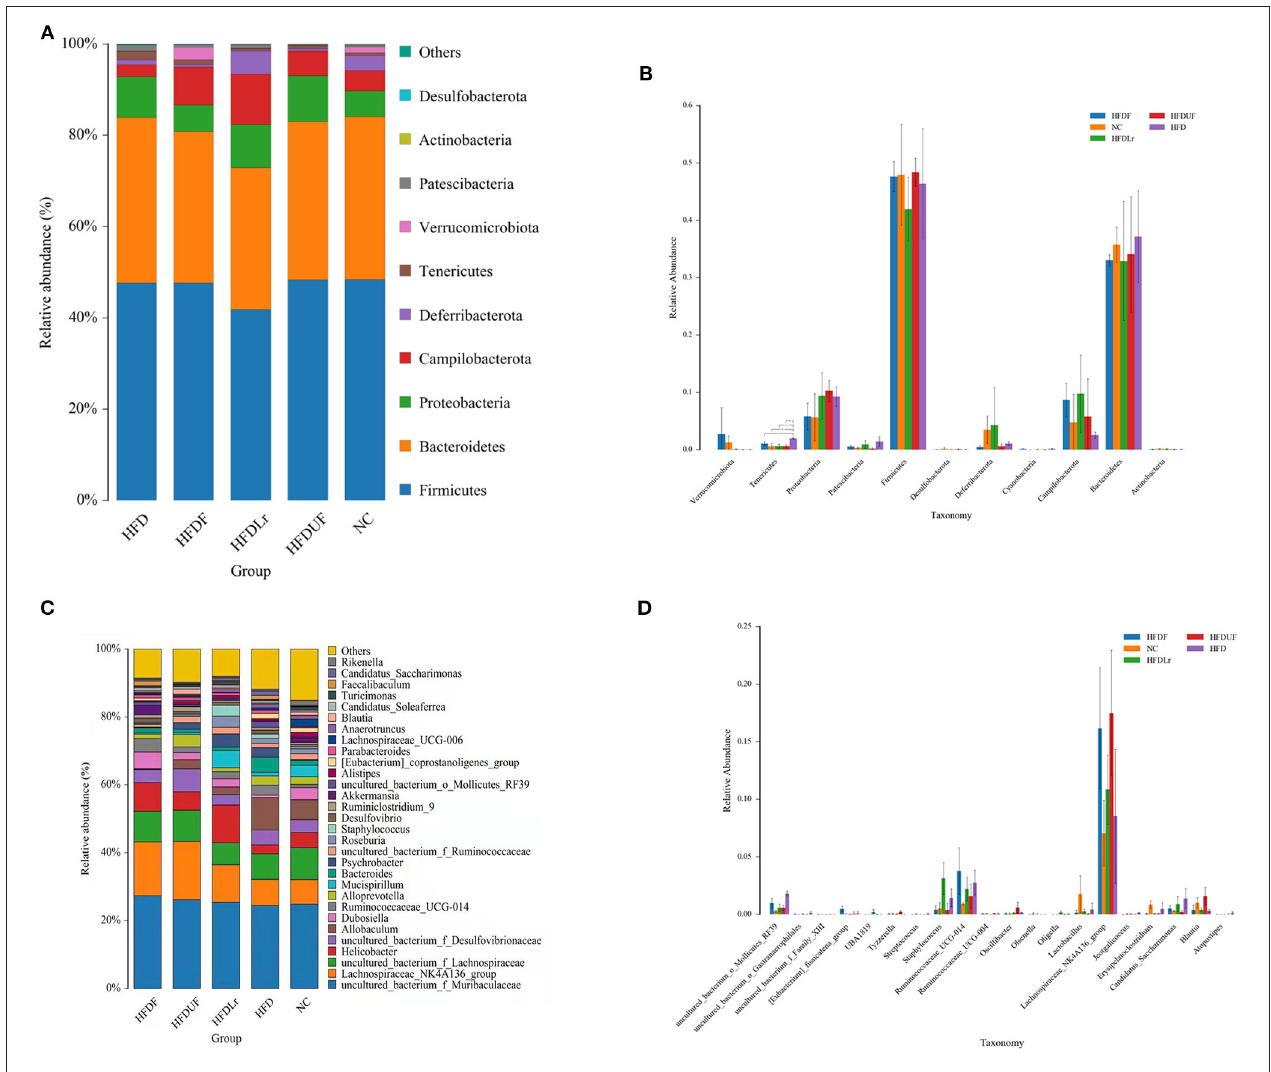
FIGURE 8 | The effects of CSM on intestinal microbiota in the HFD-fed mice. (A) Relative abundance of the intestinal microbiota at the phylum level; (B) histogram derived from the ANOVA statistical analysis of the different treatment groups at the phylum level; (C) relative abundance of the intestinal microbiota at the genus level; and (D) histogram derived from the ANOVA statistical analysis of the different treatment groups at the genus level. * p < 0.05 indicates a significant difference between